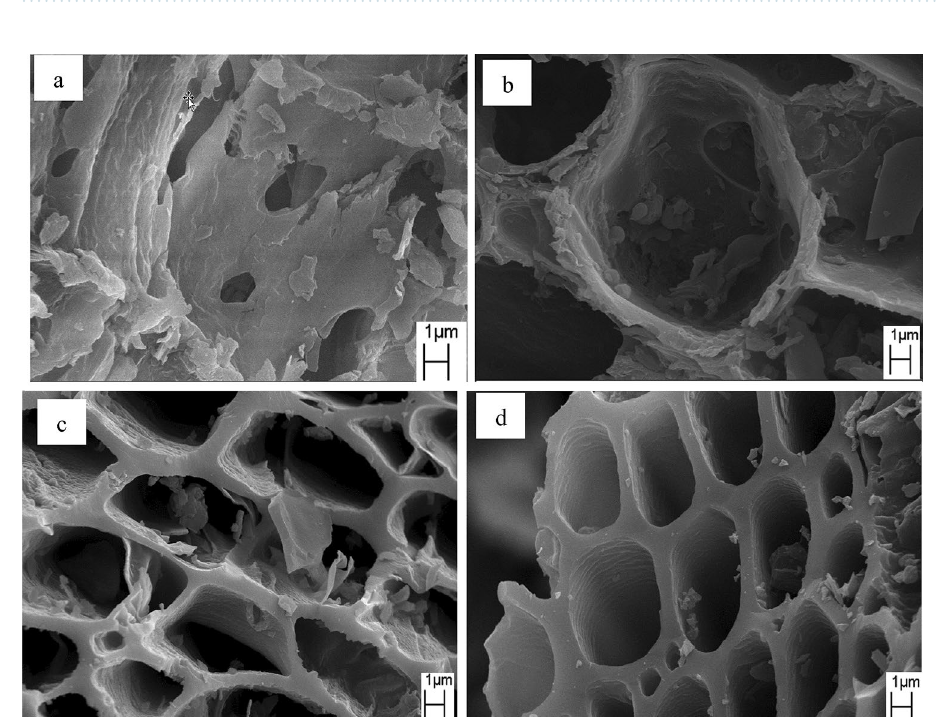
Figure 5. SEM morphology of ( a ) raw dried eucalyptus wood chips, ( b ) eucalyptus wood chip activated carbon prepared at 500 °C, ( c ) eucalyptus wood chip activated carbon prepared at 600 °C, and ( d ) eucalyptus wood chip activated carbon prepared at 700